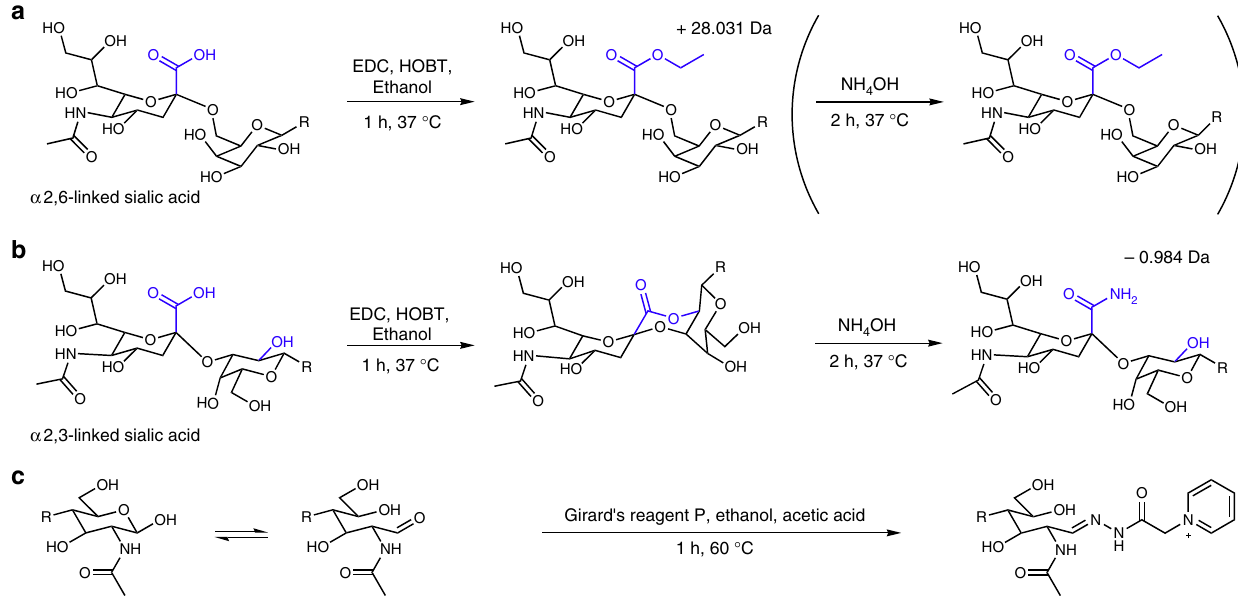
Fig. 1 Reaction scheme for the linkage-speci fi c derivatization of sialic acids and subsequent GirP labelling. a The α 2,6-linked sialic acid forms an ethyl ester during the fi rst step of the reaction and remains stable throughout. b The α 2,3-linked sialic acid initially loses water forming a lactone. After the addition of ammonia, the lactone ring is opened and a stable amide is formed. c The reducing ends of all N -glycans are labelled with Girard ’ s reagent